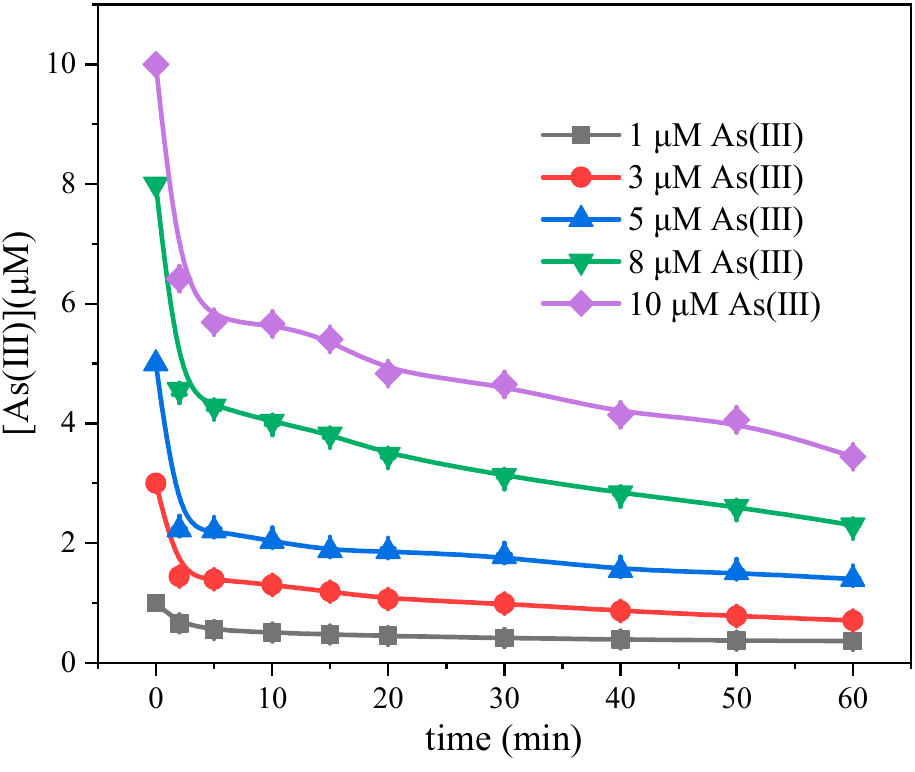
Figure 4. Effect of initial As(III) concentration on the Fe(III)-CaSO 3 system. Initial conditions: [Fe(III)] = 0.5 mM, [CaSO 3 ] = 30 mM, [As(III)] = 1–10 µ M, pH 6.0, air bubbling at 0.5 L min − 1 . Table 1. Oxidation kinetics of As(III) according to the L-H equation in the Fe(III)-CaSO 3 system. C 0 r 0 Kinetic Equation k L − H R